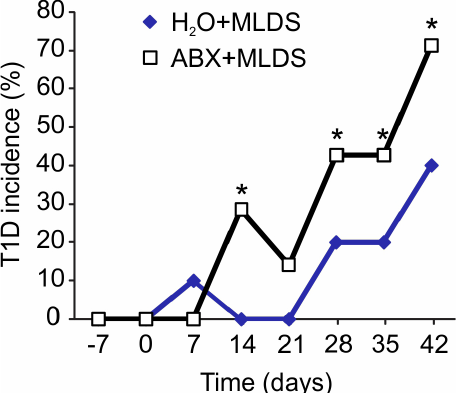
Figure 6. Incidence of T1D in antibiotics (ABX)-treated and non-treated C57BL/6 mice with MLDS- induced diabetes. Incidence (%) was calculated by dividing the number of mice with glycemia above 11 mmol/L with the total number of mice in the specific group (multiplied with 100). Day 0 on x axes represents the start of MLDS treatment. Number of mice per group was 10. * p < 0.05 was considered as statistically significant when samples from ABX+MLDS-treated and H 2 O+MLDS-treated mice were compared.